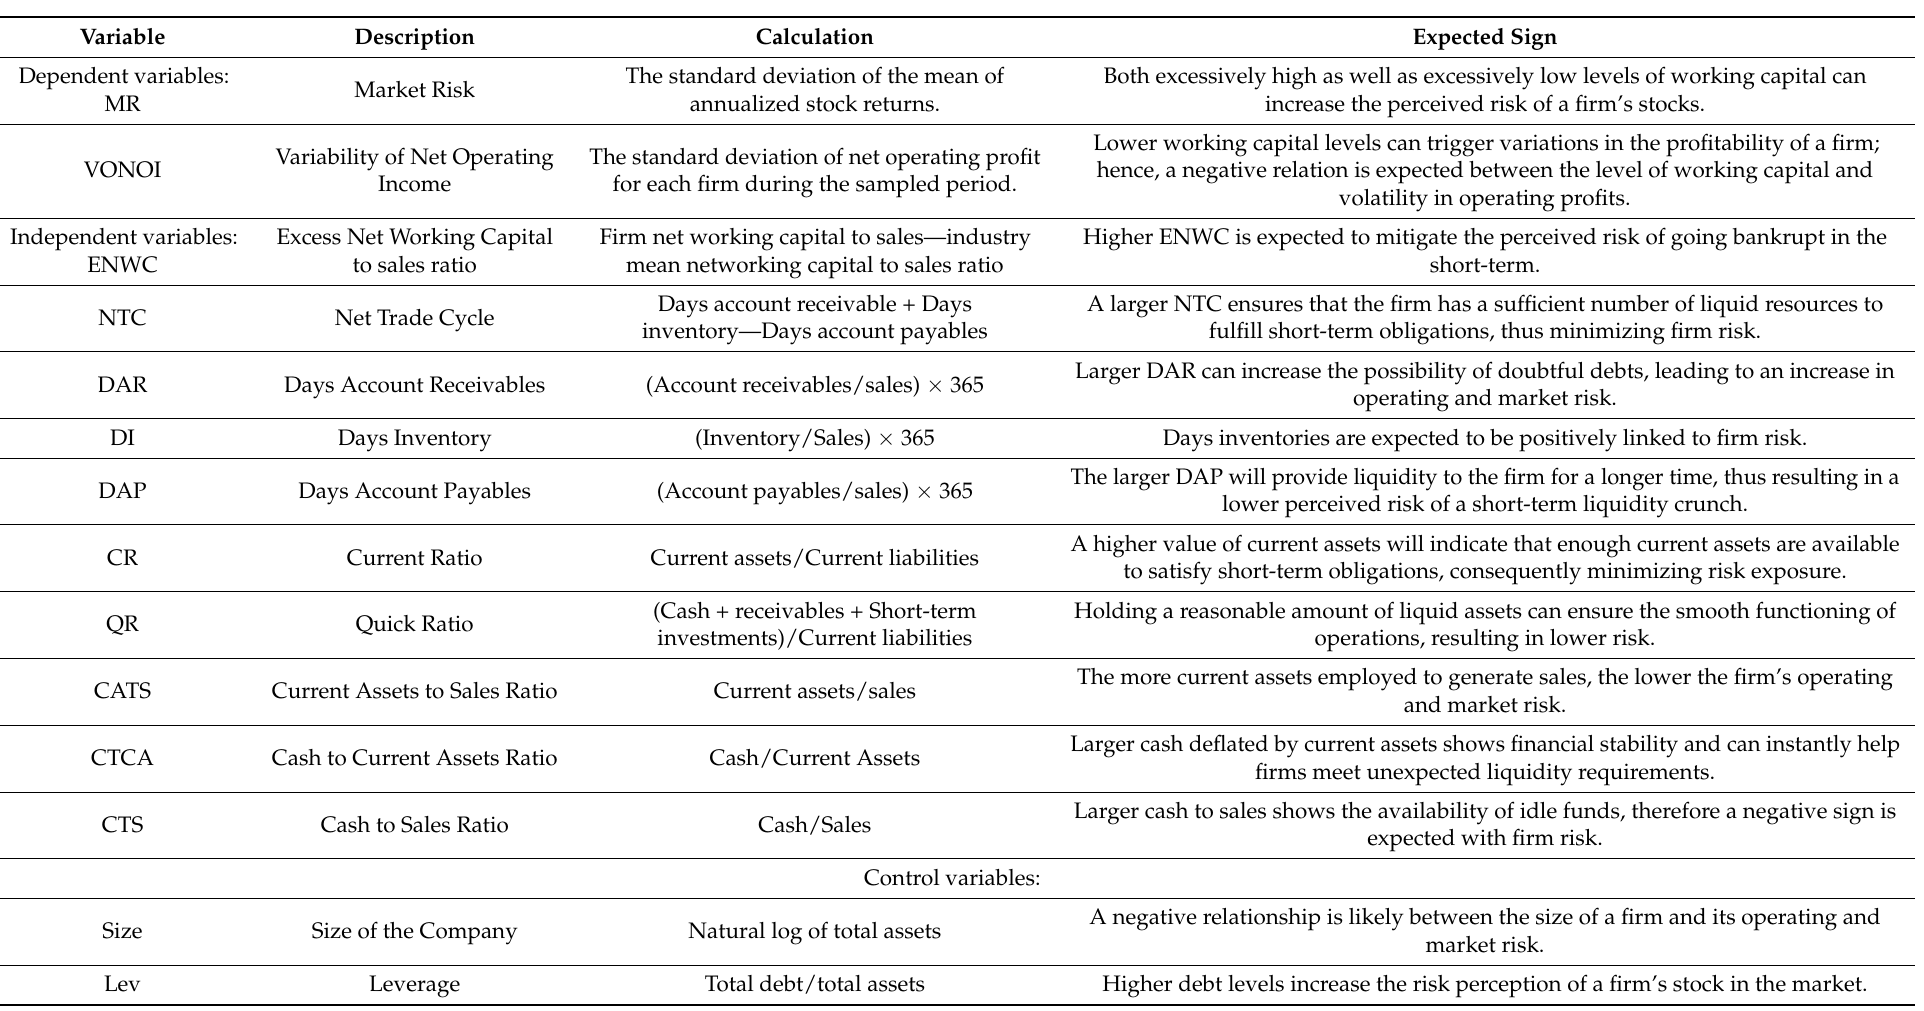
Table 2. Variable descriptions and